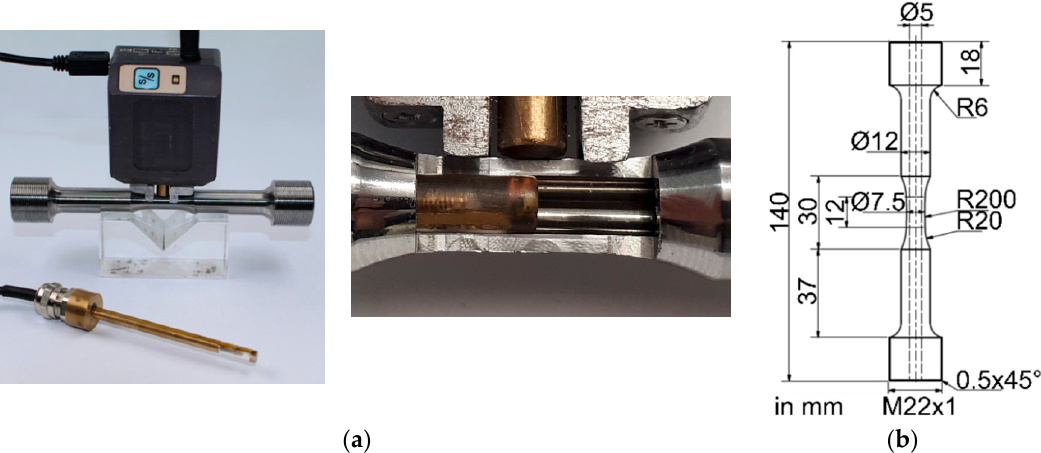
Figure 3. ( a ) custom-built inner surface sensor; ( b ) technical drawing of the deep hole drilled fatigue specimen (dimensions in mm).